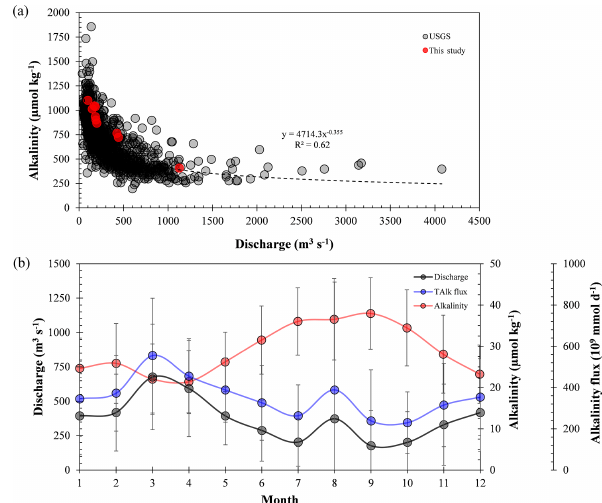
Figure 6. Relationship between alkalinity and Delaware River dis- charge at Trenton (1940–2015) (a) . Black circles indicate data ob- tained from the USGS station while red circles indicate data col- lected in this study. Seasonal river discharge versus alkalinity and alkalinity flux for the same time period (b) . Errors bars represent 1 standard deviation of the mean value for each month.